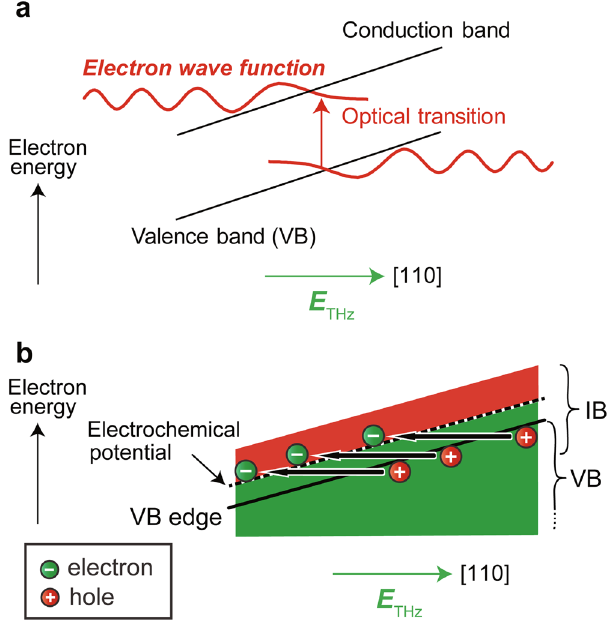
Figure 4. Magnetization modulation via the modulation of the spatial carrier distribution induced by the electric field of light. ( a ) Modulation of the band structure by the FKE. The band structure is spatially tilted by E THz , enabling optical transitions with an energy smaller than the band gap. The red curves represent the electron wave functions. ( b ) Spatial band diagram of GaMnAs while E THz is applied. The green and red regions are filled by electrons and holes, respectively. The IB and the VB overlap. Owing to the electric field, electrons in the VB can move to the